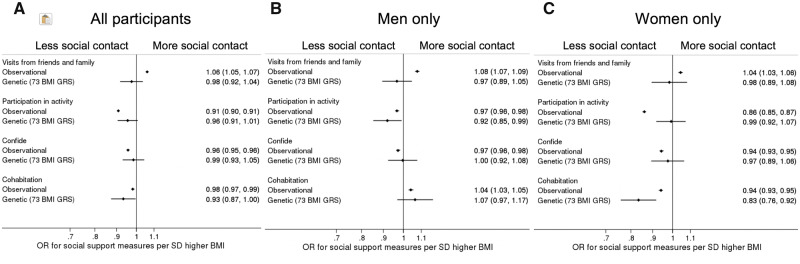
Forest plots of the linear and logistic regression and Mendelian randomization associations between a 1 SD higher BMI and the four social contact measures in (A) all individuals, (B) men only and (C) women only. Higher and lower social contact is marked on the plots as more social contact and less social contact.